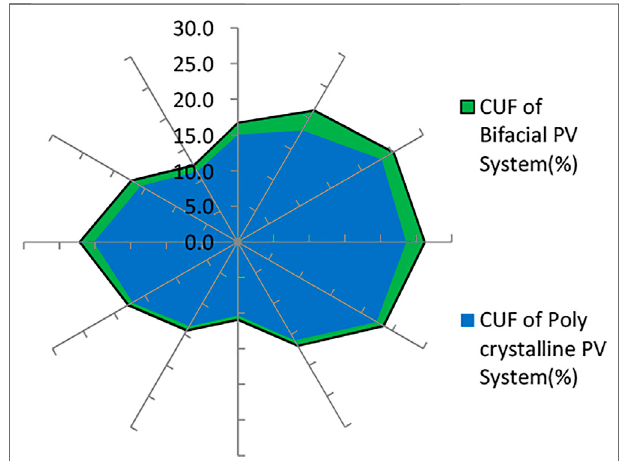
FIGURE 2 | Solar PV system monthly CUF